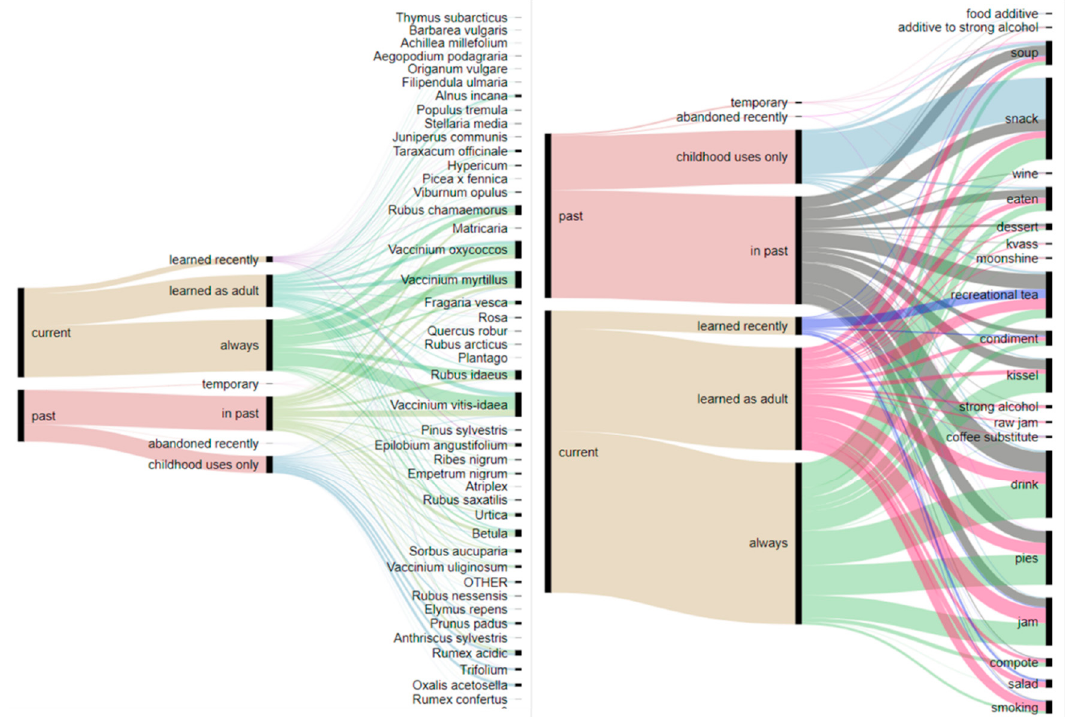
Figure 3. Alluvial diagram reflecting changes in use during the lifetime of interviewees.